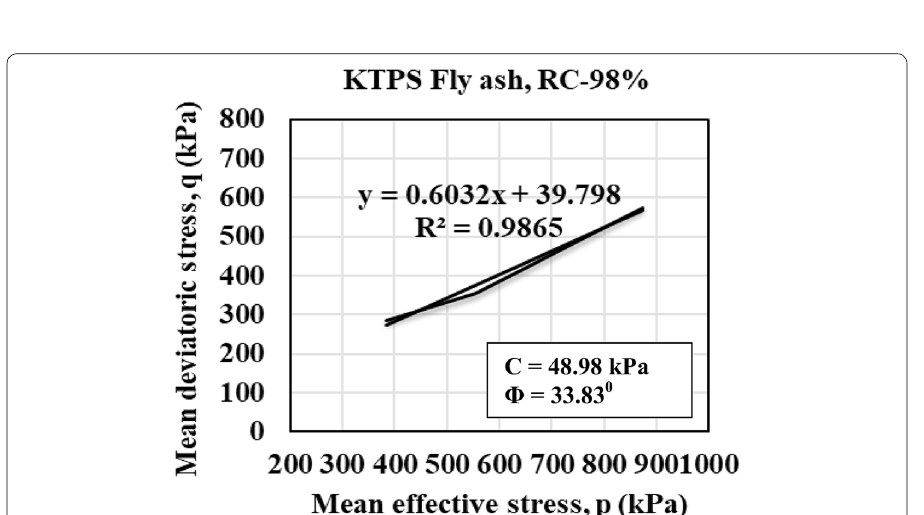
Fig. 21 p–q diagram of KTPS fly ash at